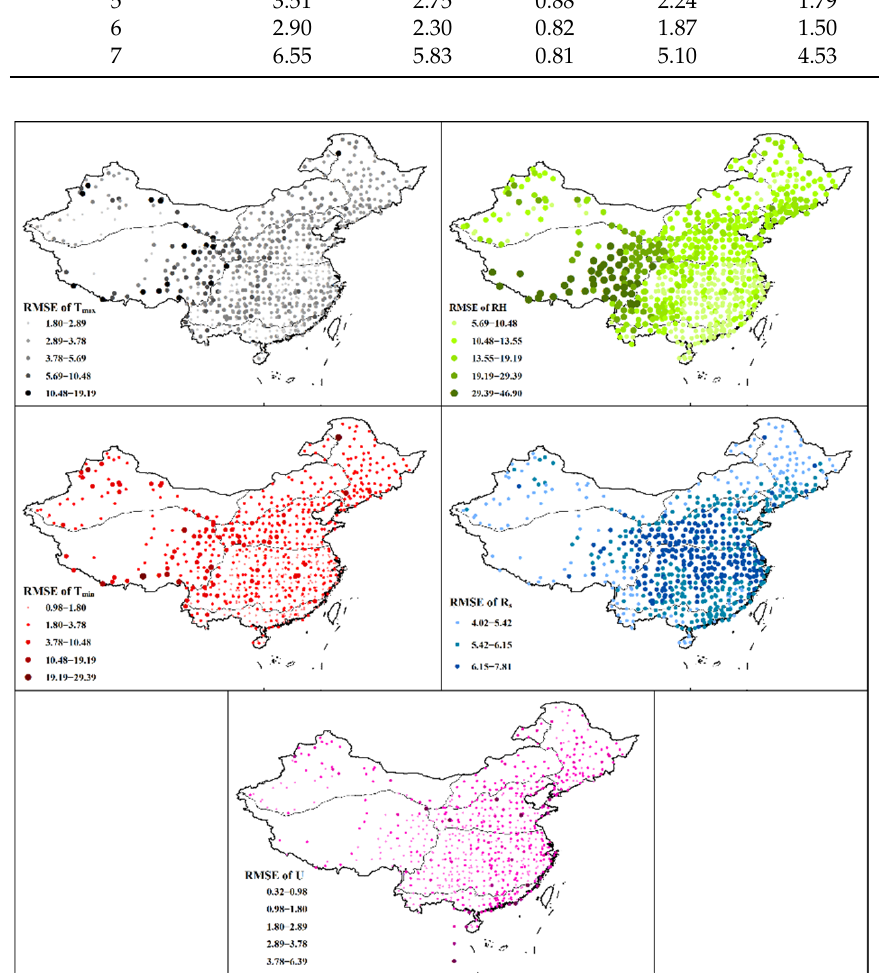
Figure 2. RMSE values of the five meteorological factors of in all stations.